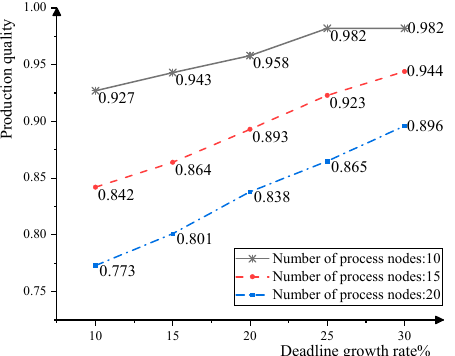
Figure 6. Impact of deadlines on algorithms VWFA.